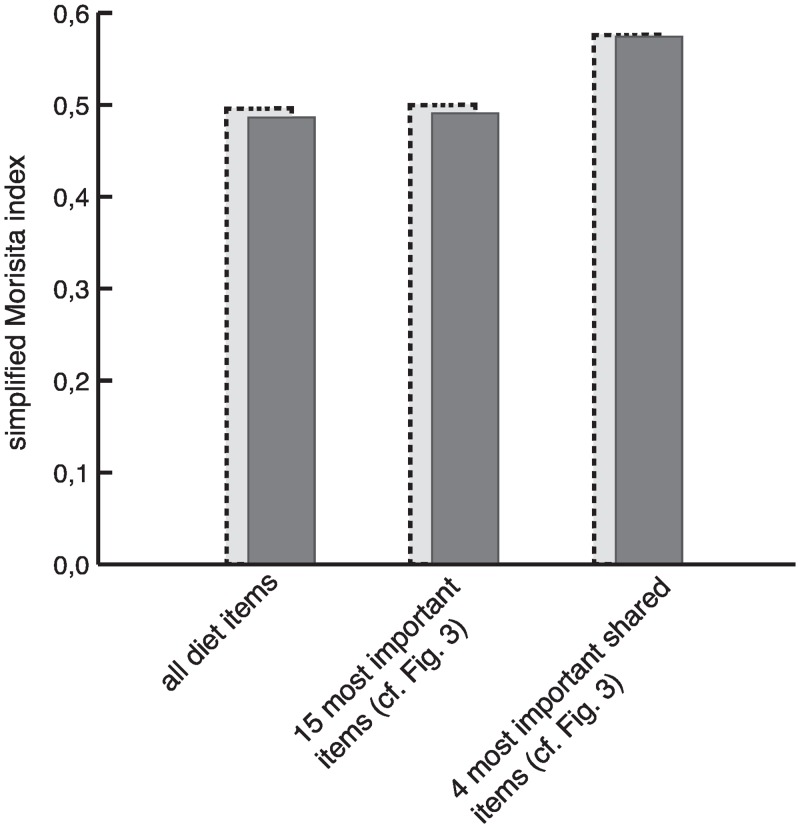
Simplified Morisita index calculated on different sets of diet items.Dark grey bars depict values calculated using all Walia ibex samples. Light grey bars with dashed frames depict values calculated using only Walia ibex samples collected at altitudes below 4000 m.